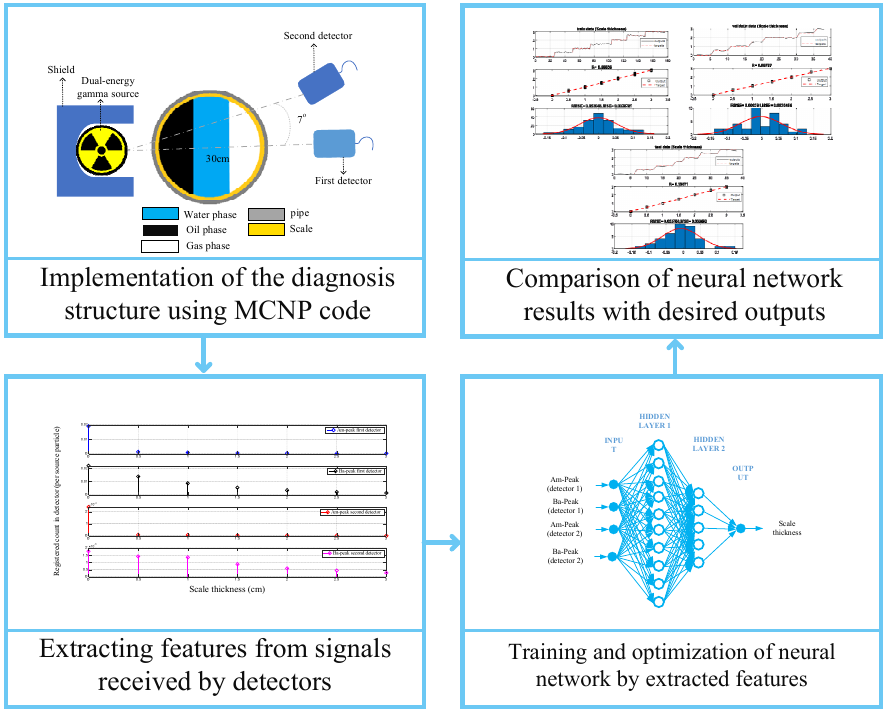
Figure 7. The general trend of the presented methodology to determine the scale thickness inside the pipe.